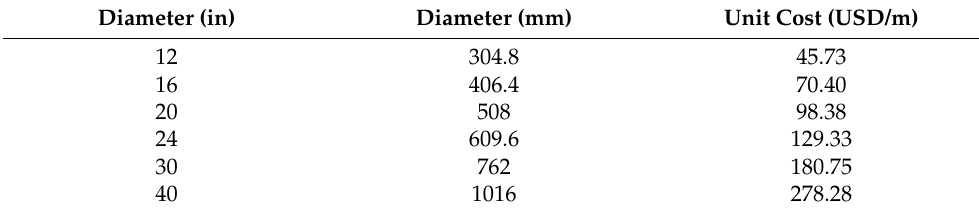
Figure 9. The Hanoi network layout. Table 7. Available pipes for selection for the Hanoi network.